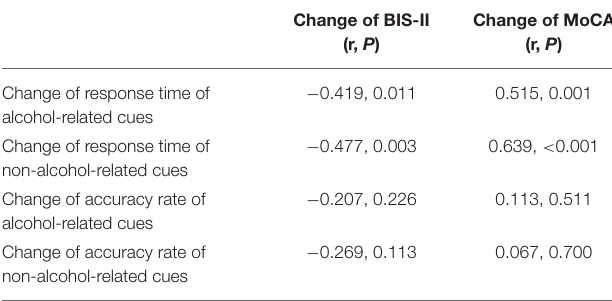
TABLE 4 | The correlation between BIC-II scores, results of the Oddball paradigm, and MoCA after rTMS in the study group ( n = 36).